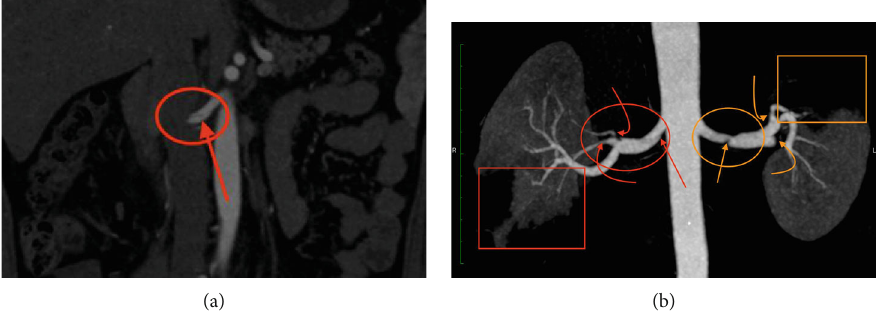
Figure 2: (a) Coronal CT angiography image and (b) anterior volume-rendered 3D MPR coronal image were obtained after intravenous contrast material in arterial phase reveals dissection fl ap (straight red arrow) of the right renal artery (red circle) in (a); (b) demonstrates focal eccentric thrombosis and attenuated fl ow and reduced caliber of the lower lobe segmental branch (curved red arrow) and upper lobe subsegmental branch (angled red arrow), resulting in infarct (red rectangular); and also demonstrates focal thrombosis in the mid-left main renal artery and dissection fl ap (orange circle), causing signi fi cant stenosis (orange straight arrow) and complete thrombosis of the middle segmental branch of the left renal artery (curved orange arrow) and partial stenosis of the upper segmental branch (angled orange arrow) with new development of infarct in some part of the mid pole as well (orange rectangular).